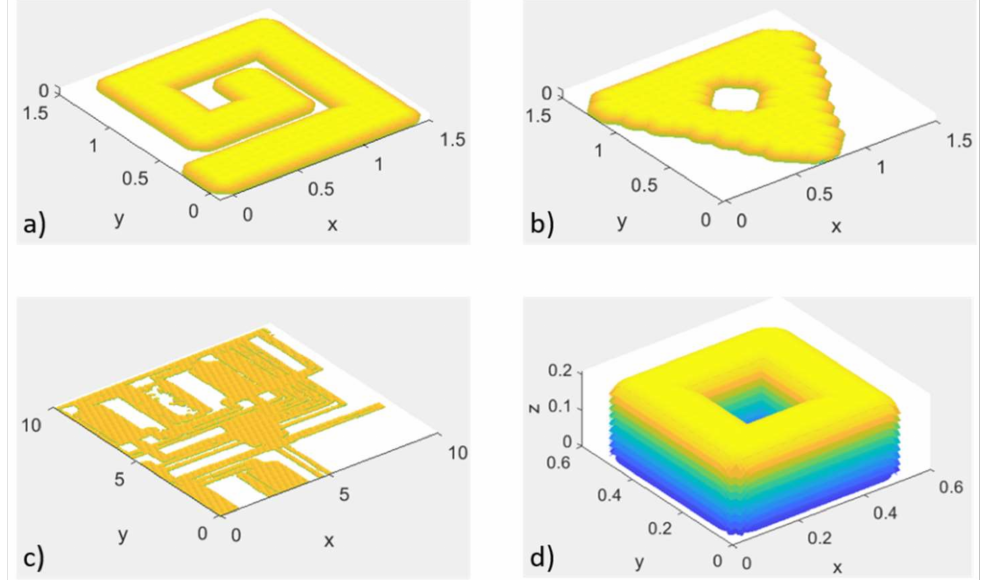
Figure 22. Simulation of different shapes with one layer in ( a – c ) and a simulation of multiple layers shape in ( d